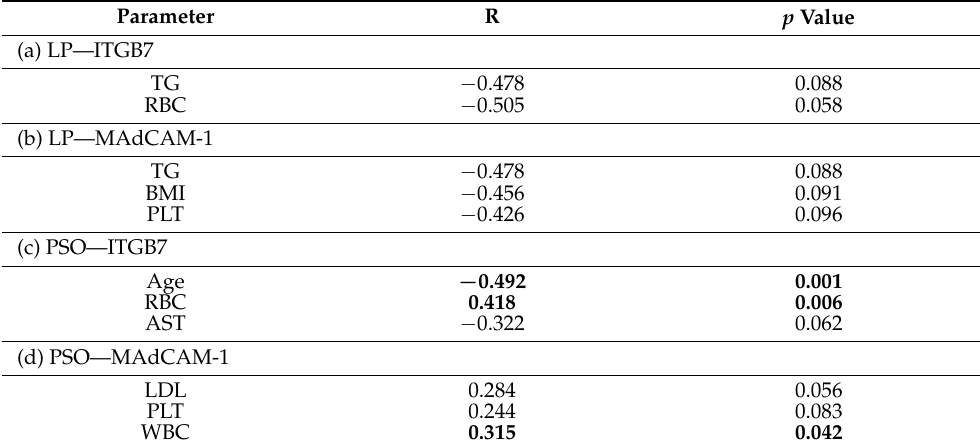
Table 3. Correlations between ITGB7 (a,c), MadCAM-1 (b,d), and patients’ parameters in LP and PSO groups. (R/ p -value).